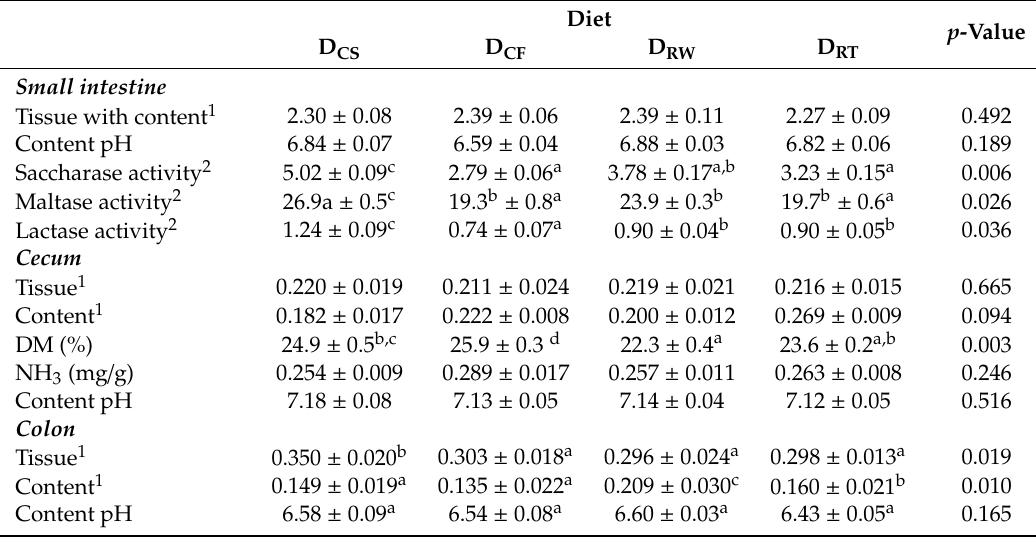
Table 4. Parameters of the small intestine, cecum, and colon of rats fed experimental diets. Data are expressed as mean ± SEM, n =